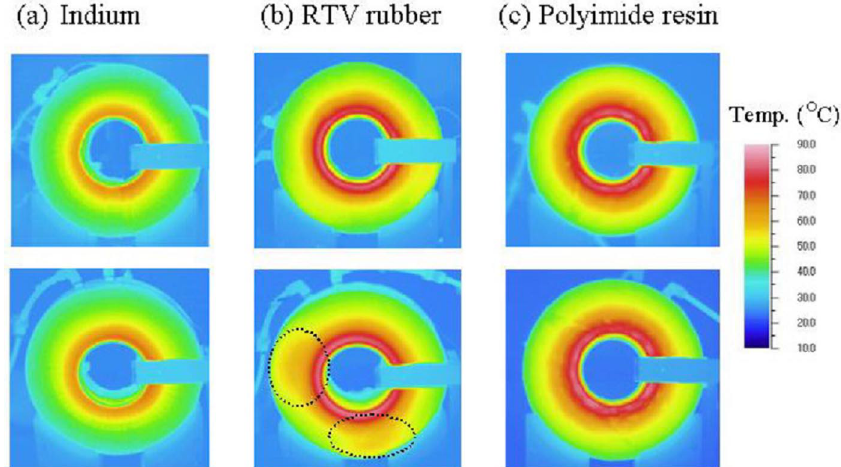
FIG. 11. (Color) Surface temperature distributions before (top) and after (bottom) the endurance tests for (a) indium-bonded, (b) - polyimide-resin-adhered, and (c) RTV-rubber-adhered cores. A RTV-rubber-adhered core shows two localized hot spots as indicated by dashed